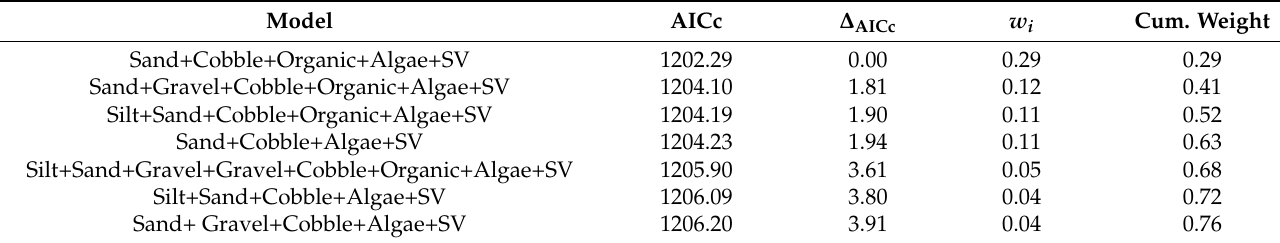
Table 4. Model selection table for the most-supported models ( ∆ AICc < 4) based on 256 candidate generalized linear mixed models to understand fish species richness-habitat associations in the St. Clair and Detroit rivers based on a shoreline seine survey from 10 sites sampled 2013–2019. “Model” indicates the fixed effects specified for individual models (SV = shoreline vegetation type), “AICc” is the Akaike information criterion with a small sample size correction, “ ∆ AICc ” is the difference in AICc for a given model and the best model, w i is the weight of support for model i and “Cum. Weight” is the cumulative weight of candidate models. All models included random effects of site and year.